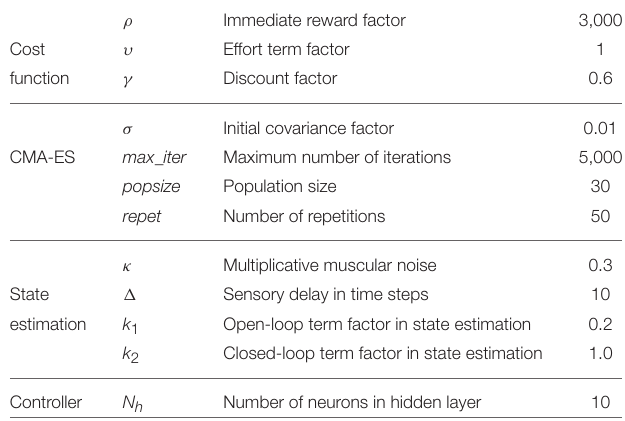
TABLE 3 | Meta-parameters of the computational